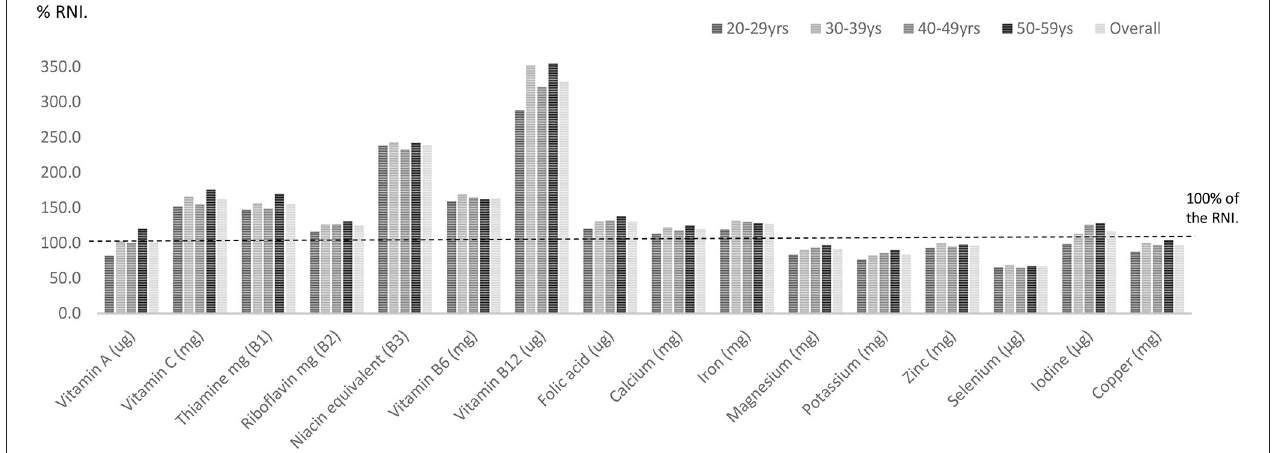
FIGURE 1 | Percentage RNI for UK males across mid-life.